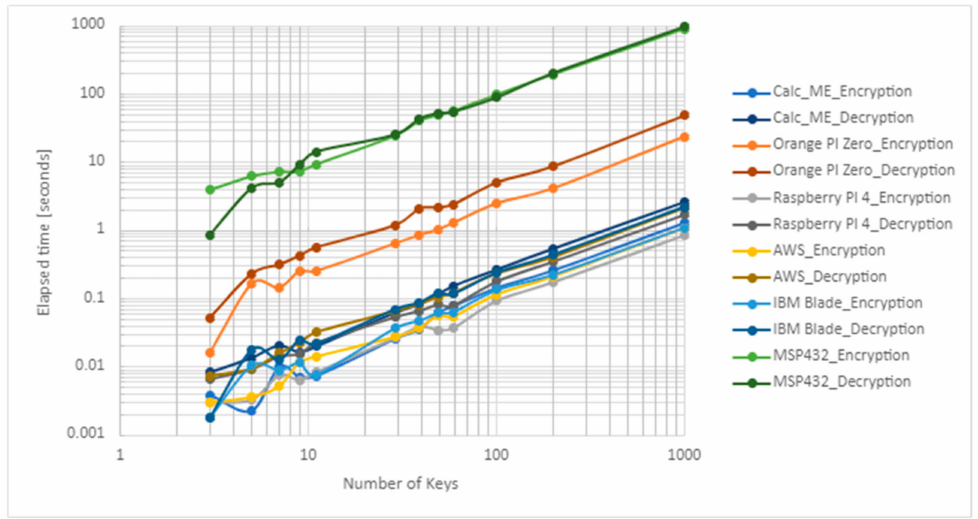
Figure 10. Encryption/decryption elapsed times for p = 400,093.